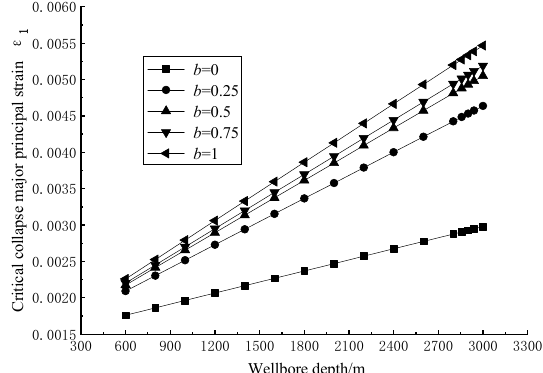
Figure 8. Critical collapse major principal strain and wellbore depth under different b values .